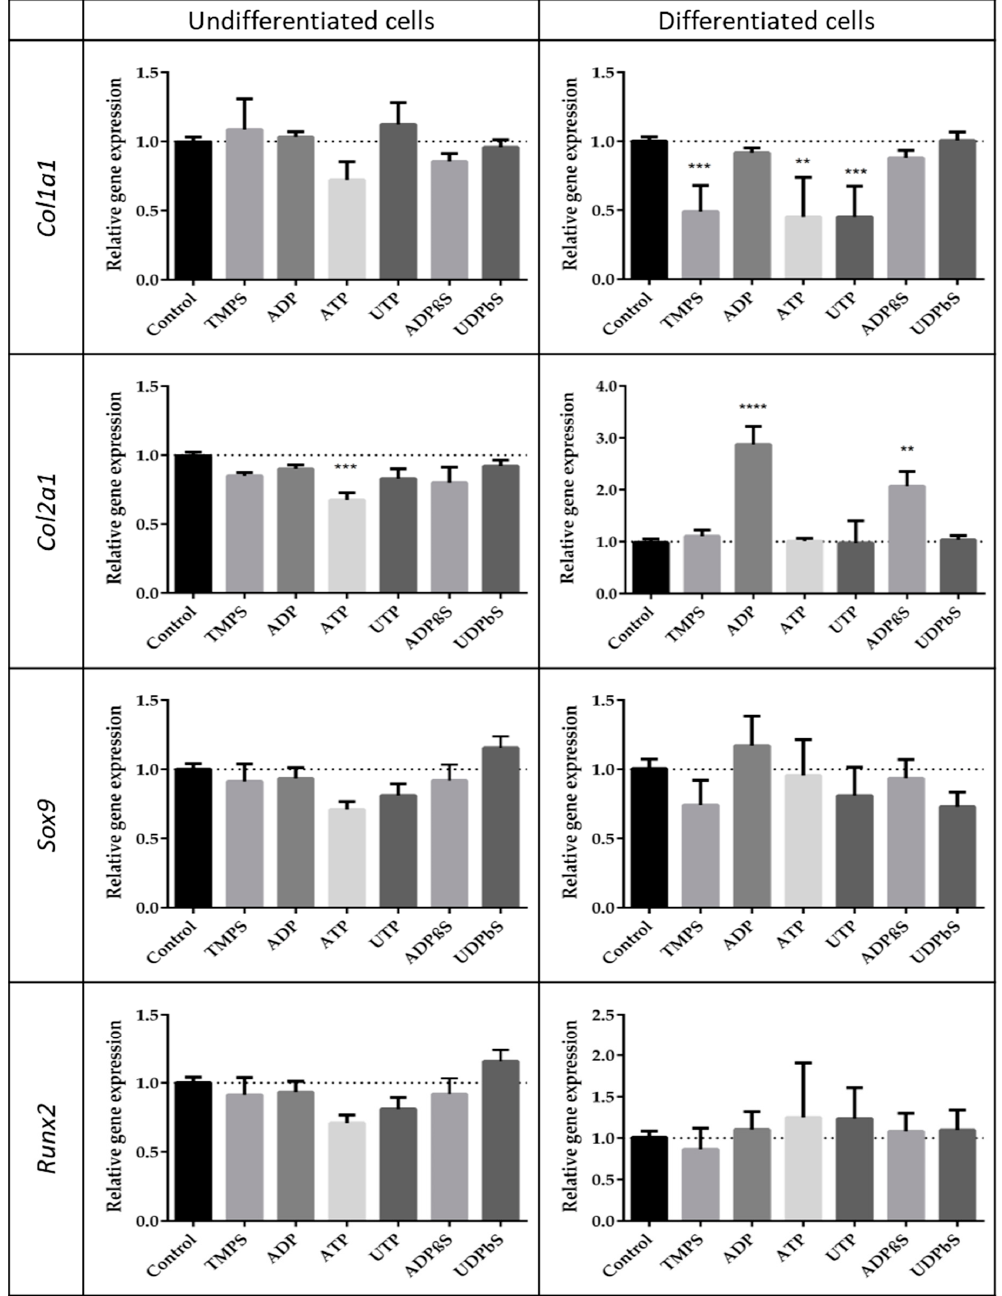
Figure 4. Expression patterns of chosen genes characteristic for the differentiation process in the presence of extracellular nucleotides or their phosphorothioate analogs. Col1a1 , Col2a1 , Sox9, and Runx2 mRNA levels were measured by RT-qPCR in ATDC5 cells grown for 48 h in standard growth medium or in differentiation medium. Each value was normalized to Gapdh the same sample. Data represent the means ± SEM from at least six independent experiments. p < 0.01 (**) and p < 0.001 (***) for gene expression significantly different from untreated control cells.